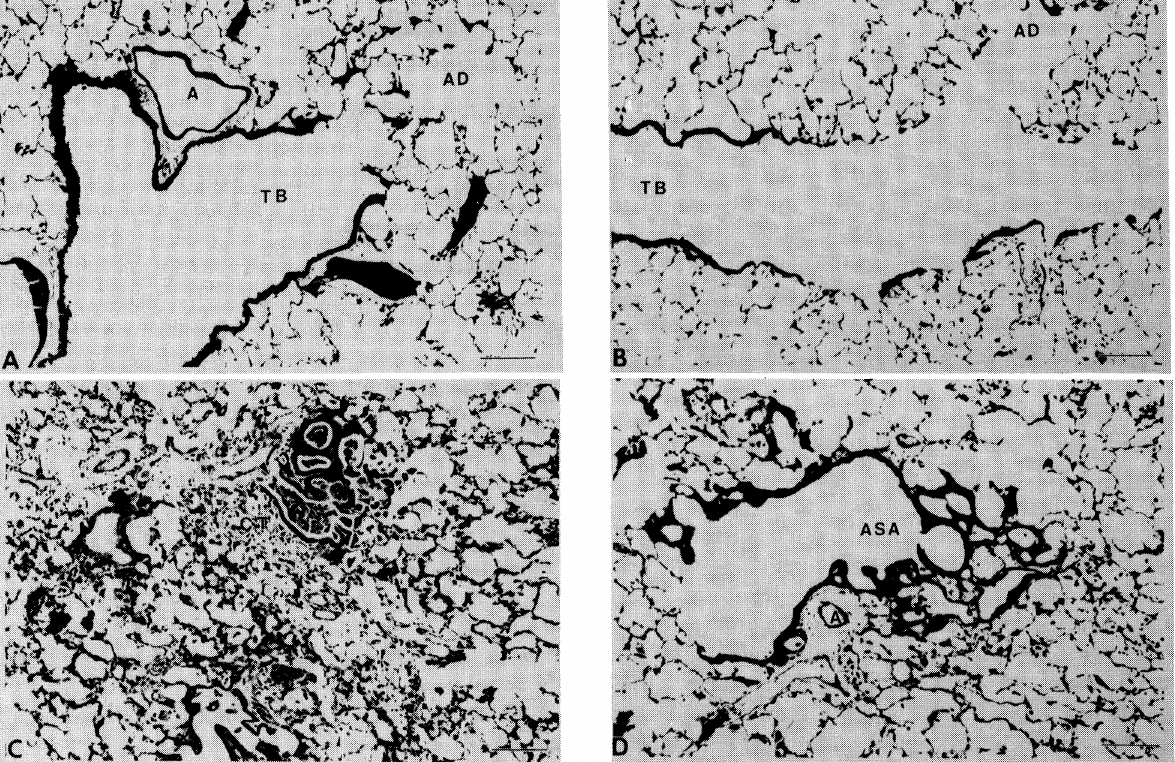
FIG. 7 Effects of WEB 2086 on amiodarone IAMD) induced parenchymal lesions of hamster lungs. See the legend to Fig. for treatment details. (A) A representative micrograph of lungs from hamsters in the saline + water group shows normal terminal broncheoles, alveolar ducts and thin interalveolar septa. (B) A representative micrograph of lungs from hamsters in the WEB + water group shows normal terminal bronchioles, alveolar ducts and thin interalveolar septa. (C) A representative micrograph of lungs from hamsters in the saline + AMD group shows abnormal small airways with aggregations of airway inflammatory cells (arrowheads). Note the adjacent areas of thickened septa and organized connective tissue. (D) A. representative micrograph of lungs from hamsters in the WEB + AM D group shows an abnormal small airway and a few thickened septa. Note the reduced severity of inflammation and fibrosis in this treatment group. A arteriole, TB terminal bronchiole, AD alveolar duct, ASA abnormal small airways, CT organized connective tissue, bar 100